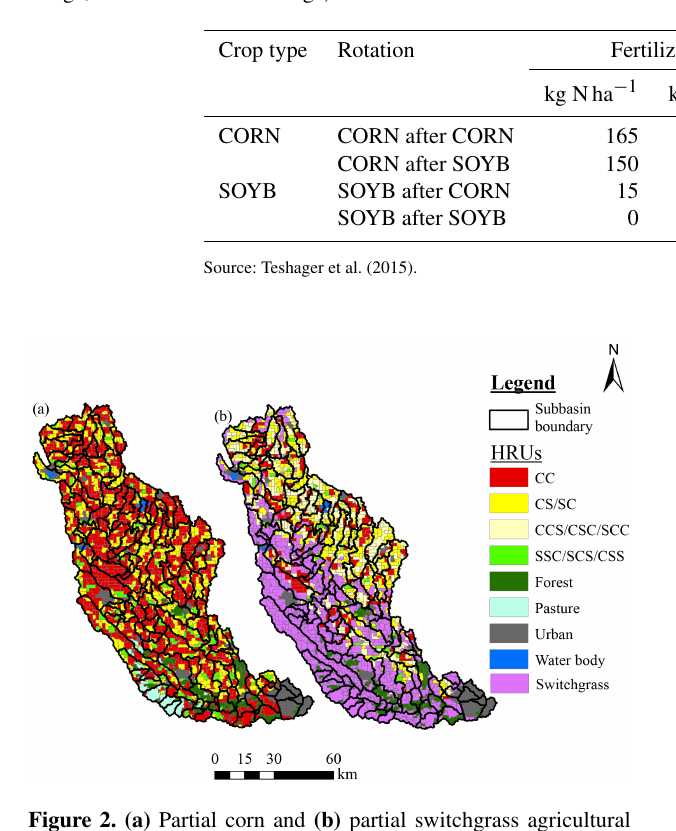
Table 2. Fertilizer/manure application rates and presence of tiles and tillage practices (SOYB is soybeans, NT is no-till, Cs is conservation tillage, Cv is conventional tillage).